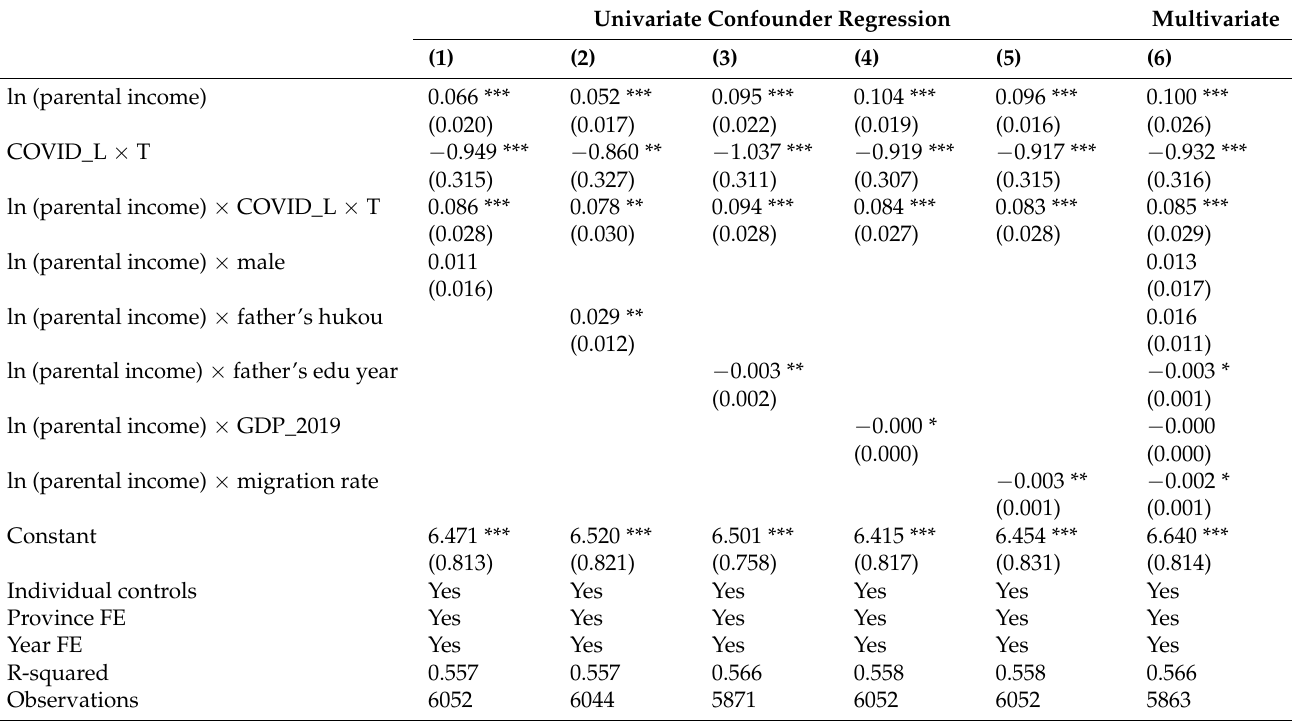
Table 4. Robustness checks include family- and province-level